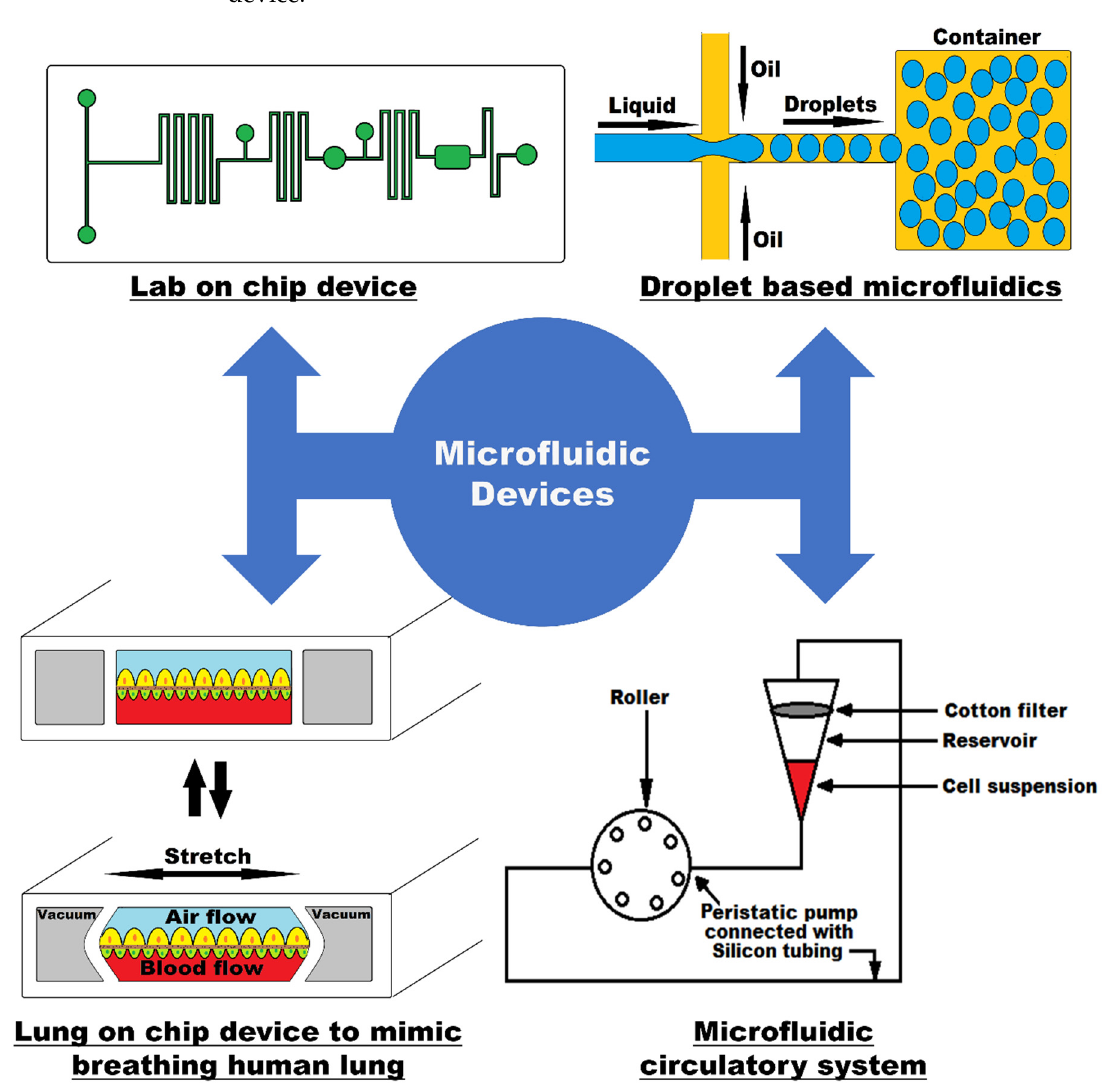
Figure 1. Microfluidic devices showing lab-on-a-chip, droplet-based microfluidics, organ-on-a-chip, and circulatory system that can produce the shear stress mimicking the human physiological